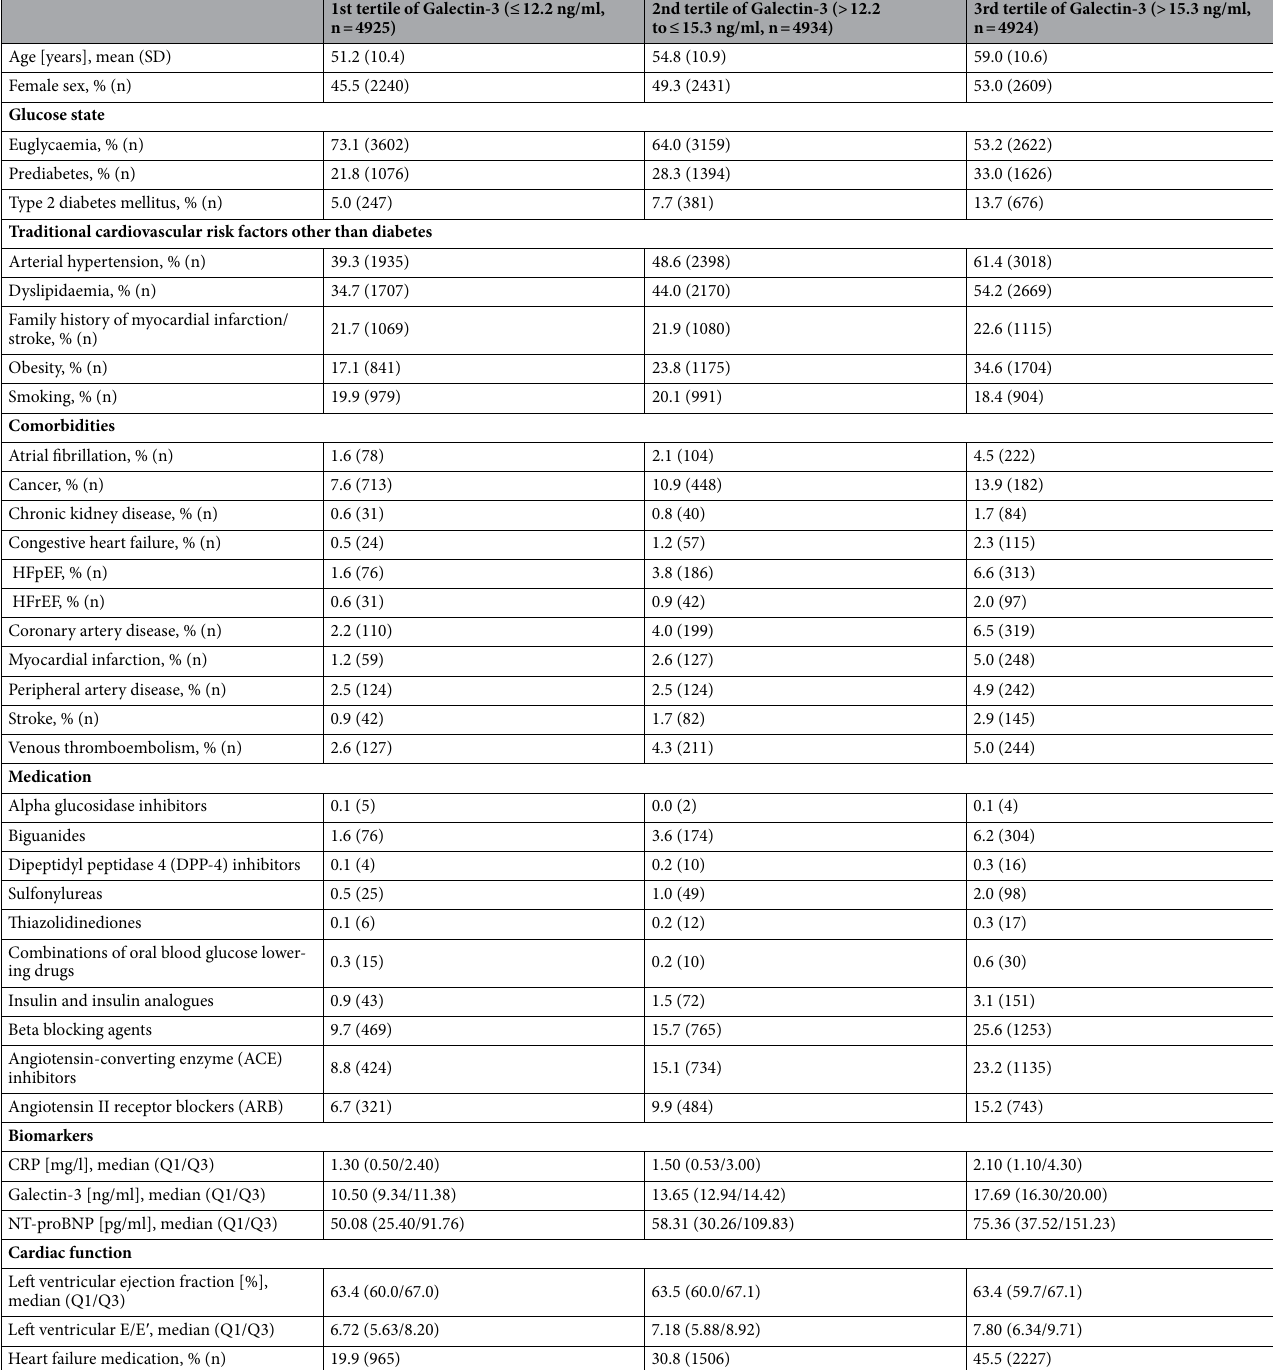
Table 1. Galectin-3 tertiles and the prevalence of diabetic status, cardiovascular risk factors, comorbidities, cardiac function (n = 14,876). Continuous variables are expressed by mean values with standard deviation (SD) or median with interquartile range (Q1/Q3). Discrete variables are described through relative and absolute frequencies. Heart failure medication according to ATC codes C09 (angiotensin converting enzyme